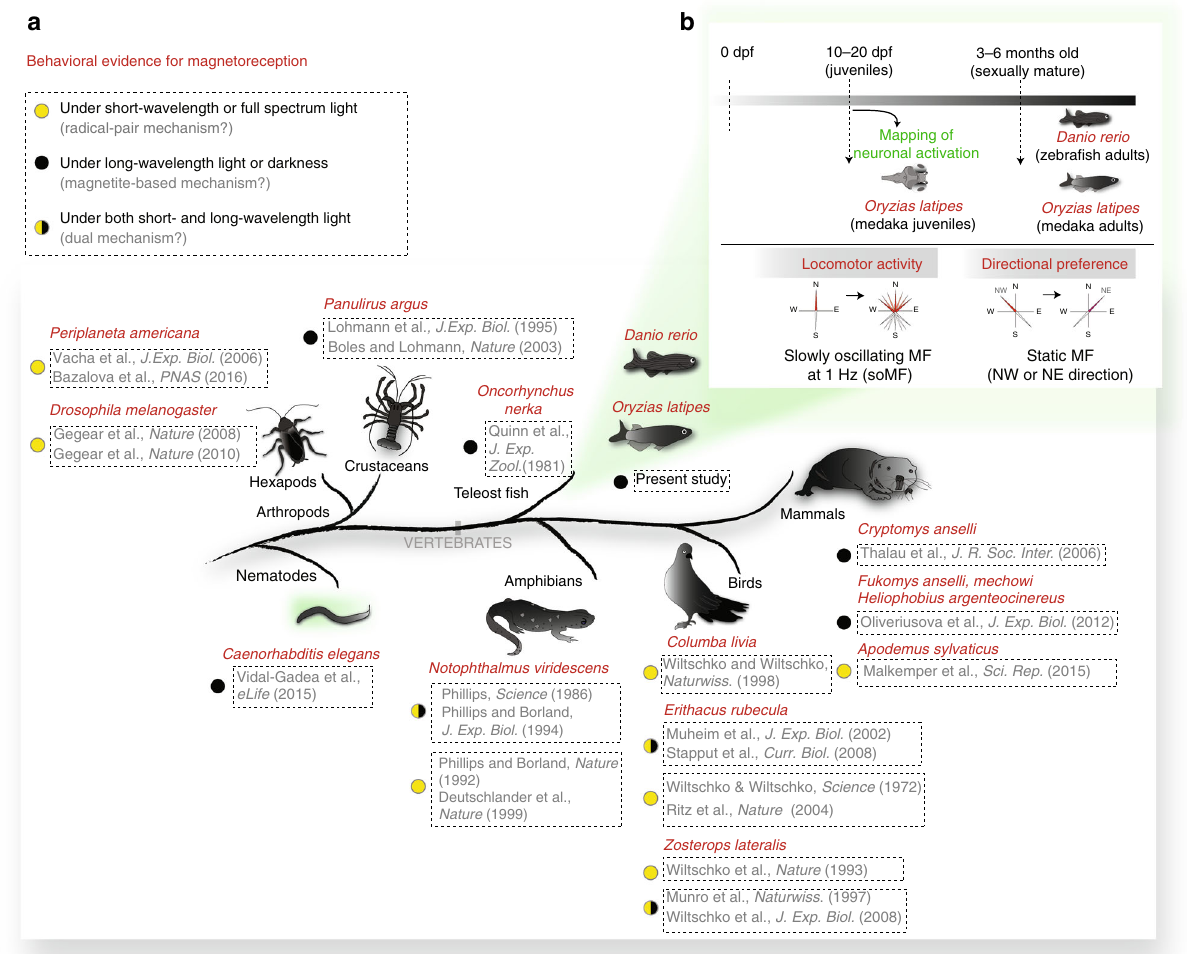
Fig. 1 Behavioral evidence for magnetoreception across the animal kingdom. a Schematic summarizing the major experimental evidence for magnetoreception in invertebrates and vertebrates as reported in the selected studies. The colored circles next to the references indicate whether the behavioral experiments provide evidence for a light-dependent mechanism (i.e. consistent with the “ radical pair hypothesis ” , yellow), for a light- independent mechanism (i.e. working under long-wavelength light or darkness, not consistent with a radical pair mechanism but consistent with the “ magnetite hypothesis ” , black) or for the presence of a dual mechanism (yellow/black). The green shadow indicates genetic model organisms that are accessible by whole-brain optical imaging. b Design of the present study performed on zebra fi sh and medaka at different developmental stages. Both juveniles and sexually mature fi sh were studied by customized behavioral assays ( “ locomotor activity ” for juveniles and “ directional preference ” for sexually mature fi sh). Neuronal activation during the “ locomotor activity ” assay was mapped in medaka juveniles. dpf: days post